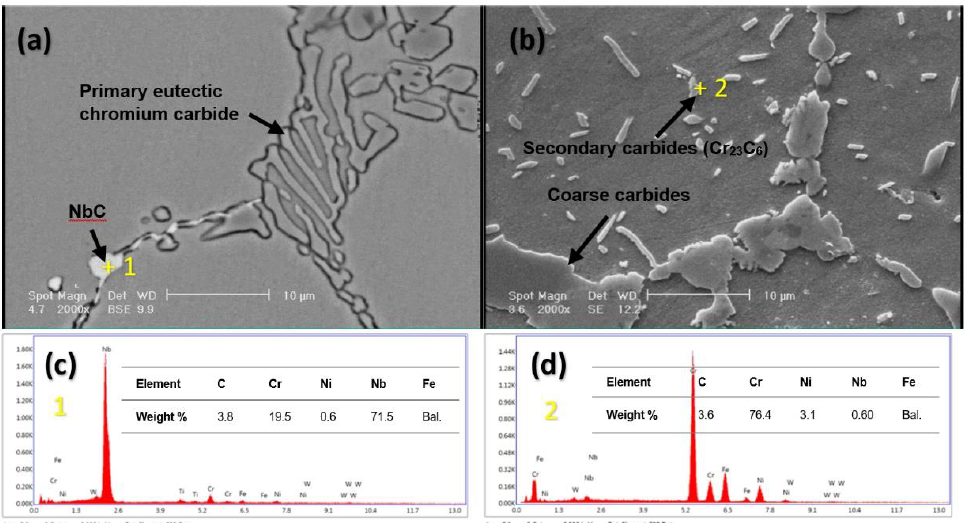
Figure 2. SEM images of Tube A ( a ) as-cased, and ( b ) after exposure to reformer service conditions for 46,000 hours, ( c , d ) point elemental analysis of present phases using EDS system.